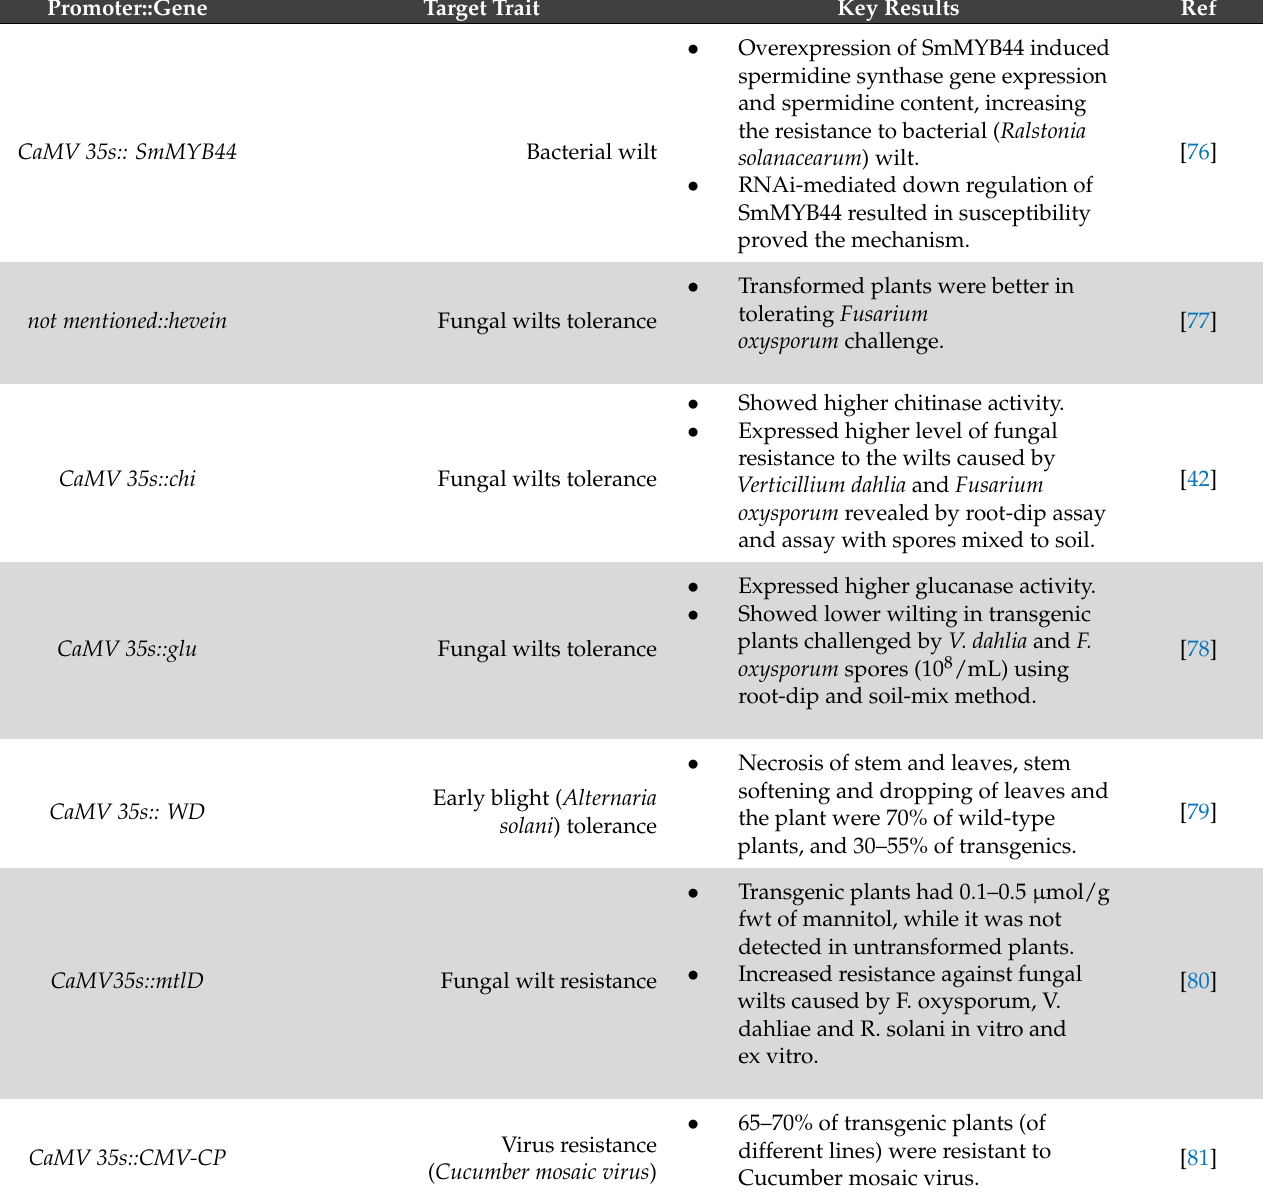
Table 4. Transgenic eggplant resistant to